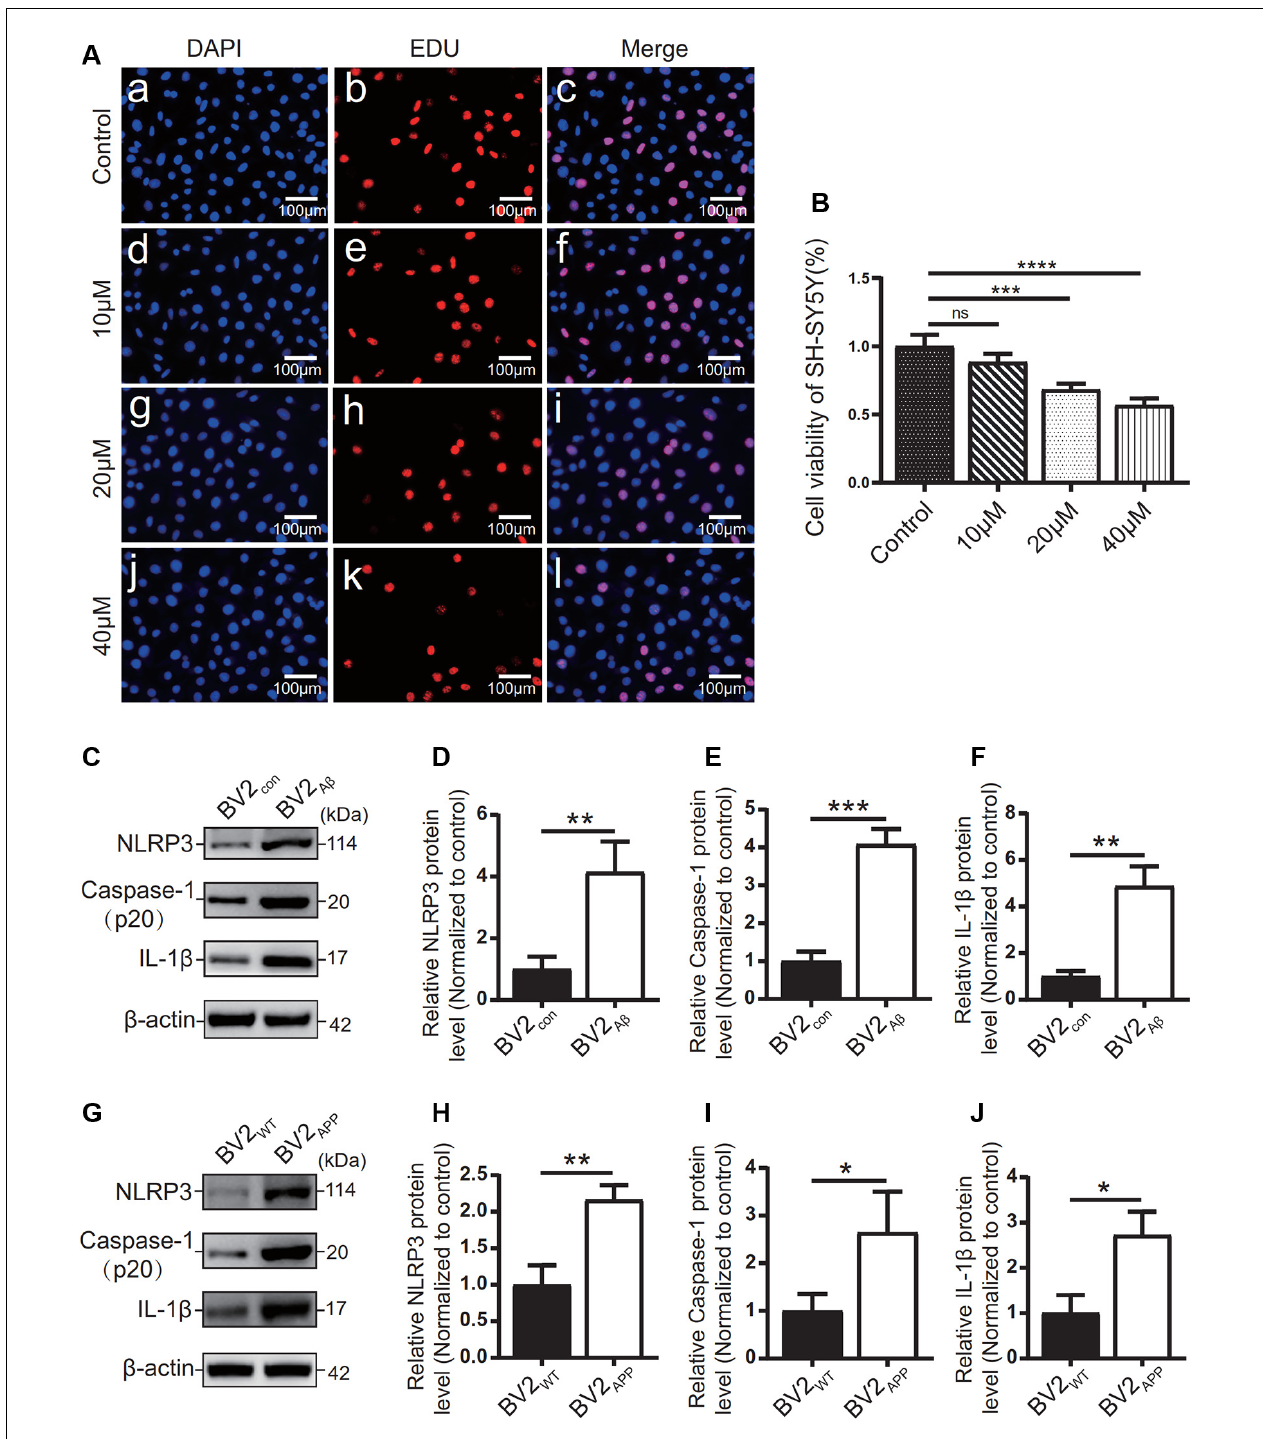
FIGURE 5 | Influence of A β 25–35 on SH-SY5Y and expression of inflammatory proteins in AD cell models. (A) DAPI and EdU staining were used to observe the number of nuclei in the SH-SY5Y cells treated with 10, 20, and 40 µ M A β 25–35 for 24 h, and (B) the proliferation ratio of each group was calculated. BV2 cells were cocultured with SH-SY5Y cells or SH-SY5Y cells supplemented with A β 25–35 for 24 h. (C) The expression of the NLRP3, caspase-1, and IL-1 β proteins in BV2 cells was detected by Western blots. (D–F) The relative gray value of protein expression in each group was compared. After BV2 cells were cocultured with APP WT or APPswe cells. (G) Western blotting was used to detect the expression of NLRP3, caspase-1, and IL-1 β . (H–J) The relative gray values of NLRP3, caspase-1, and IL-1 β in each group (* p < 0.05, ** p < 0.01, *** p < 0.001, **** p < 0.0001; “ns” means there is no significant difference; n = 3).